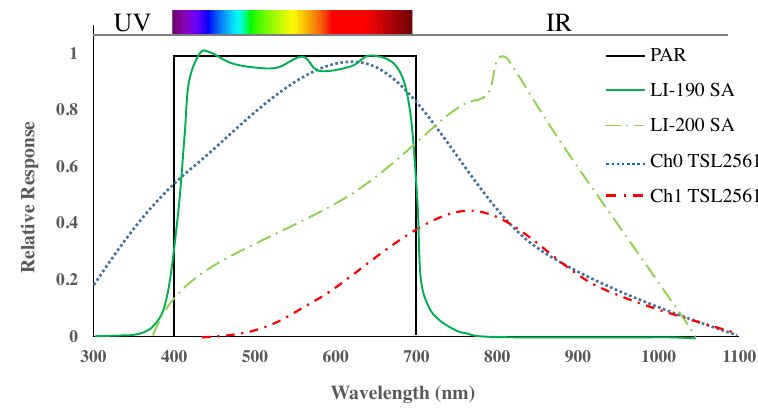
Figure 9. Wavelength sensitivity for the LI-190 SA, the LI-200 SA and the two outputs from the